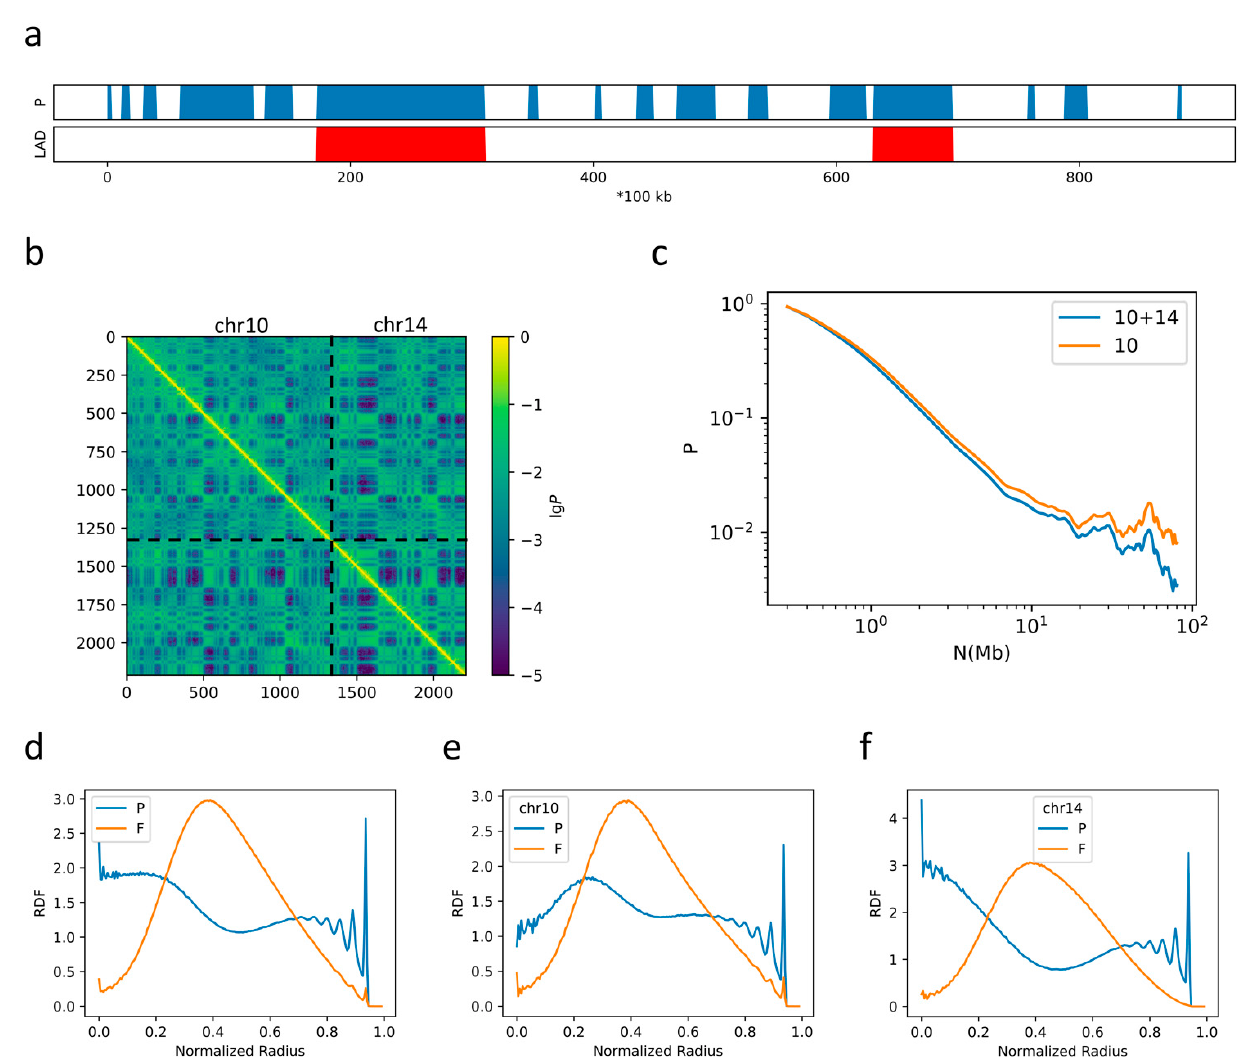
Figure 2. ( a ) The P-domain and LAD annotation of chr14; ( b ) The contact map generated from simulations on chr10 and chr14; ( c ) the average contact probability as a function of the sequential distance; ( d ) the radial distribution functions (RDF) obtained for chr10+chr14 simulation; ( e ) the RDF of Chr10 from the 2-Chr simulation; ( f ) the RDF of Chr 14 in the 2-Chr system.